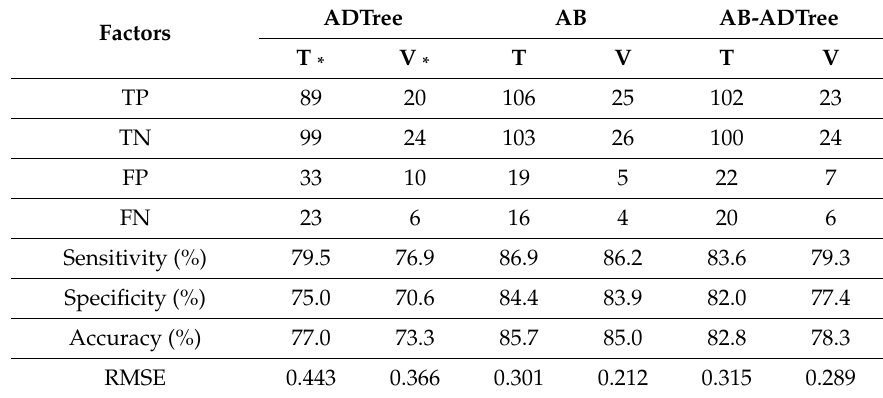
Table 3. Goodness-of-fit and prediction accuracy of the models for the training and validation datasets. ADTree AB Factors